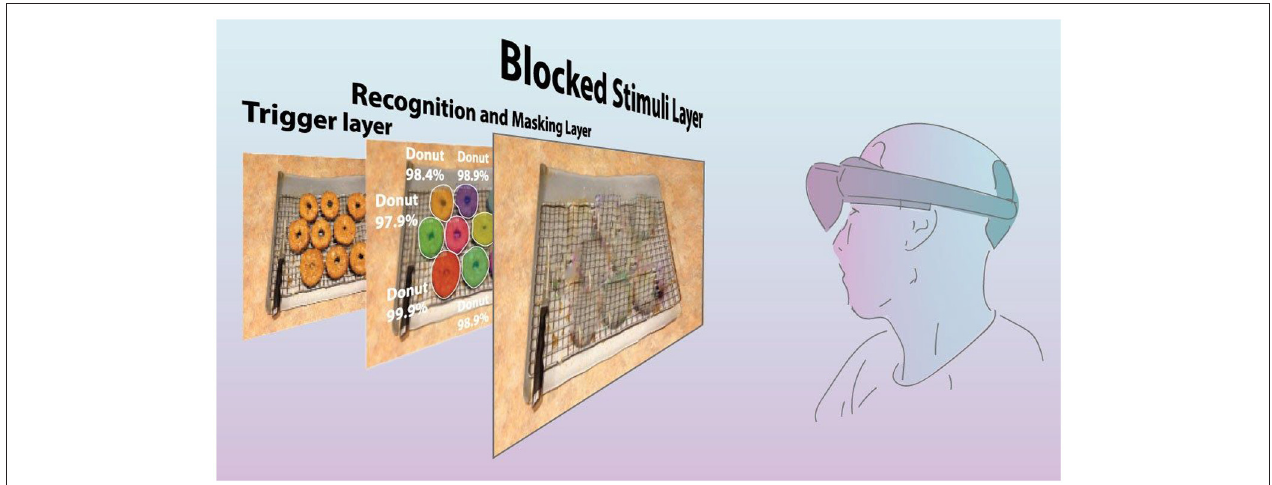
FIGURE 9 | Diagram showing close-loop scenario where stimuli are removed from user perception. The trigger layer shows a stimulus that the user intends to avoid. The recognition layer is computed on the user’s device and masks the stimuli to be blocked. The blocked stimuli layer is what the user perceives when a trigger stimulus is